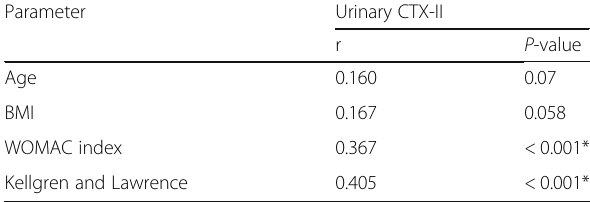
Table 2 Correlation between urinary CTX-II and the parameters